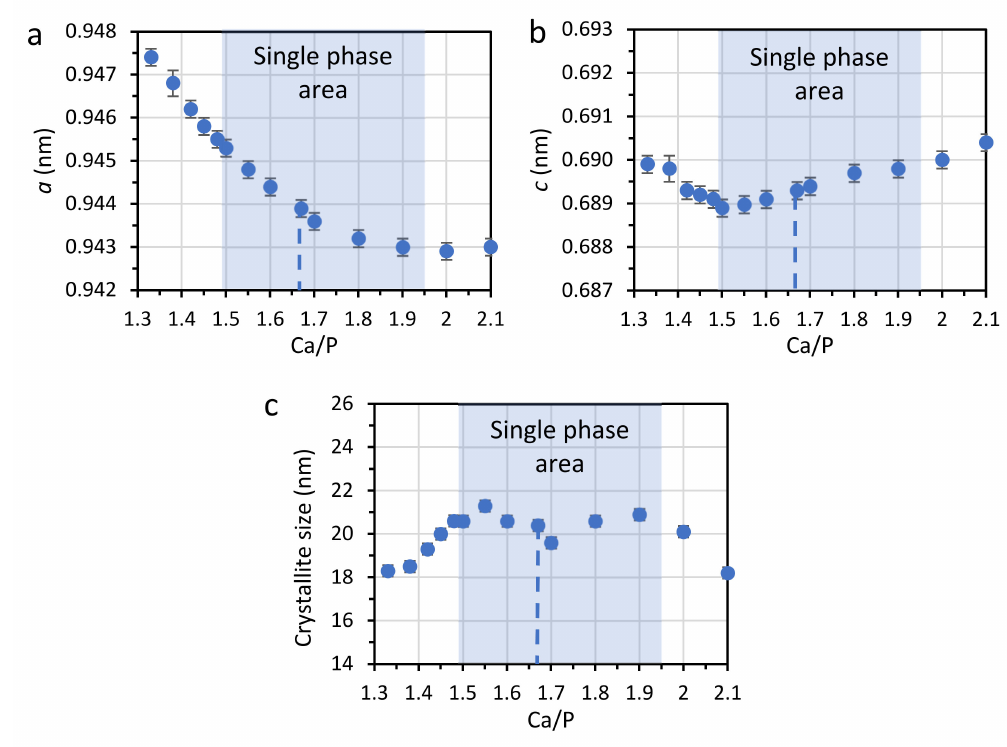
Figure 2. Dependence of the HAp lattice parameters a ( a ) and c ( b ) and crystallite size ( c ) on the Ca/P ratio.